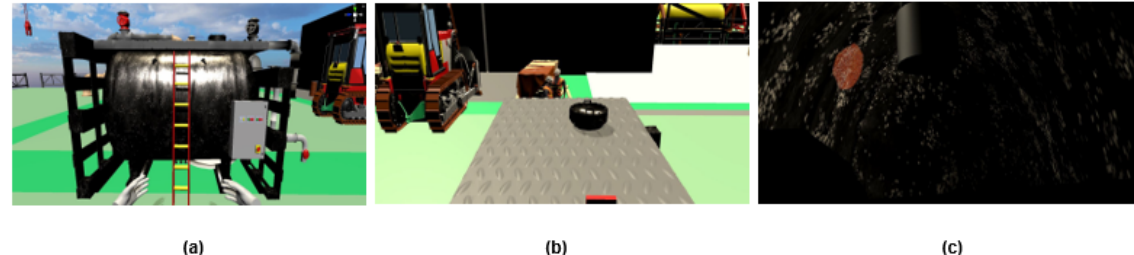
Figure 3. Module 2 Confined space inspection: ( a ) Oil tank with ladder. ( b ) View when standing on top of tank. ( c ) Dark surrounding when inspecting inside of tank.